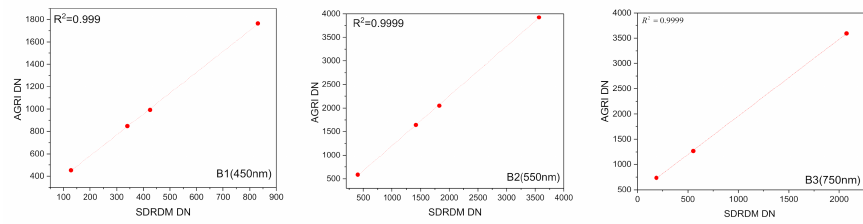
Figure 4. Response relationship of the AGRI and the SDRDM with the same radiance